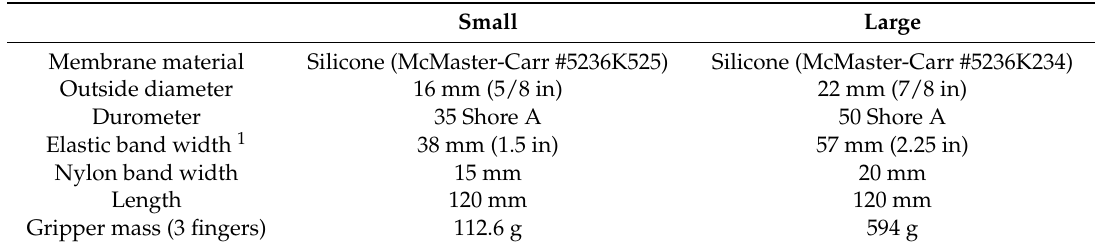
Table 1. Finger specifications for both the small and large versions.